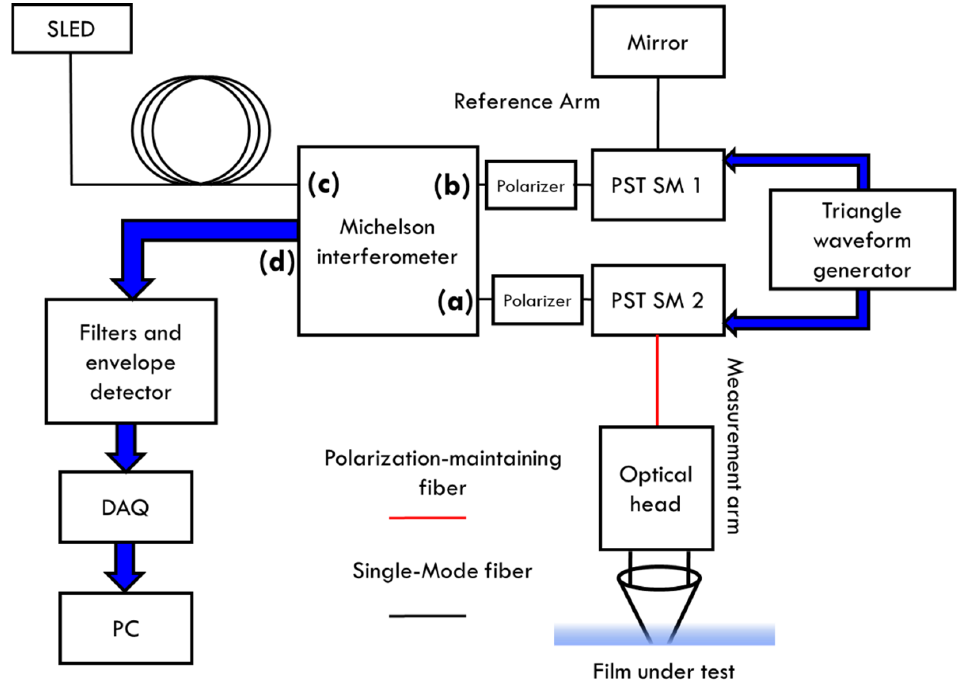
Figure 3. Scheme of the first prototype of low-coherence interferometer. SLED is superluminescent diode; DAQ is Data Acquisition card; PST SM is Piezo Stretcher with Single Mode fiber; PC is Personal Computer: ( a ) is measurement output; ( b ) is reference output; ( c ) is SLED input; ( d ) is electrical output.